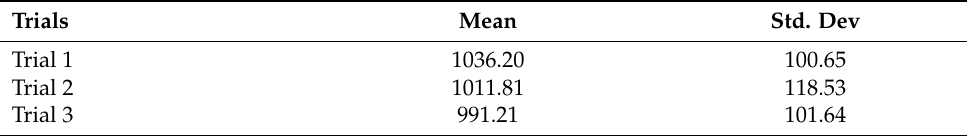
Table 1. Descriptive statistics for response